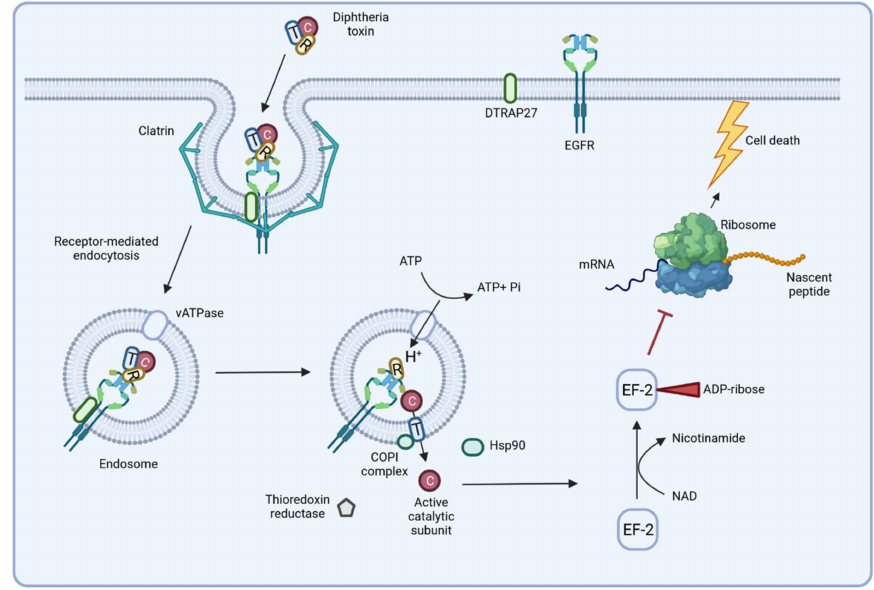
Figure 5. Delivery and action of diphtheria toxin. The B-subunit of the toxin binds to the host receptor HB-EGF, leading to receptor-mediated endocytosis. Once in the endosome, acidification of the lumen induces pore formation, and the catalytic domain of the toxin is released into the cytoplasm. ADP ribosyltransferase activity of the catalytic domain inactivates elongation factor 2 (EF-2) and protein biosynthesis stops, inducing cell death by apoptosis (see below) (figure created with